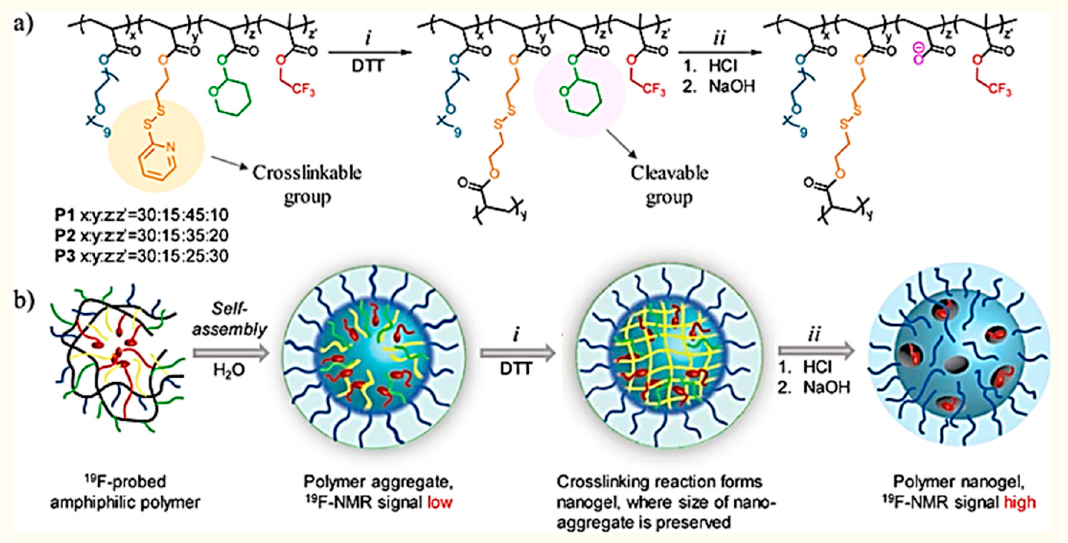
Figure 3. Design and synthesis of fluorinated probe. (a) Structure of polymer and nanogel. (i) Nanogel formation via crosslinking of PDS groups with DTT (ii) Cleavage of THP group in the presence of HCl and formation of negatively charged moiety with NaOH addition. (b) Schematic representation of preparation of fluorinated nanogel with decreased interior density. Reproduced from [242] with permission from American Chemical Society, 2019.